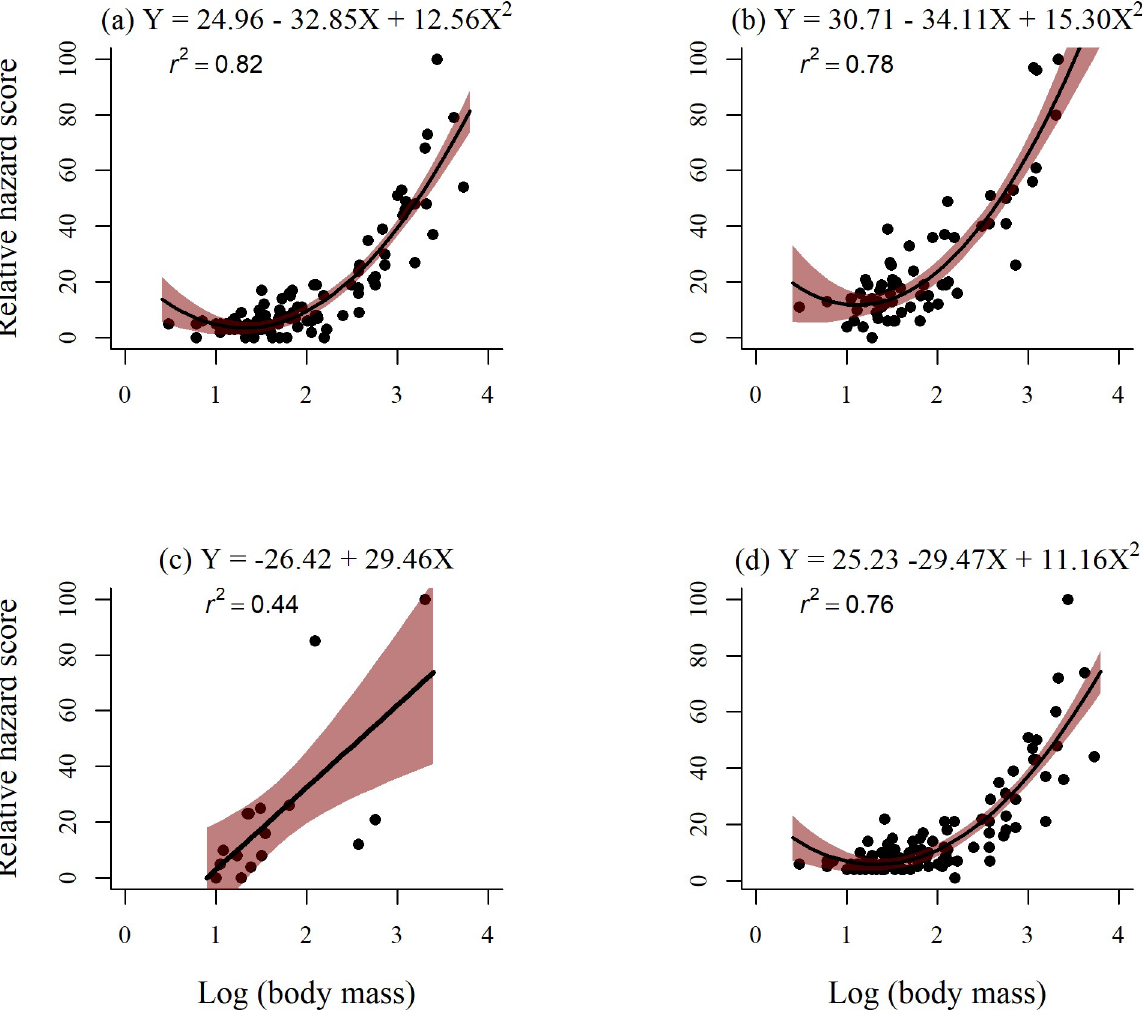
Fig 2. Relationship between avian body mass and relative hazard score for avian groups with military cargo (a), fighter (b), rotorcraft (c) and all military airframes (d). Only strikes identified to species and occurred within the U.S. were included. Strike data are from